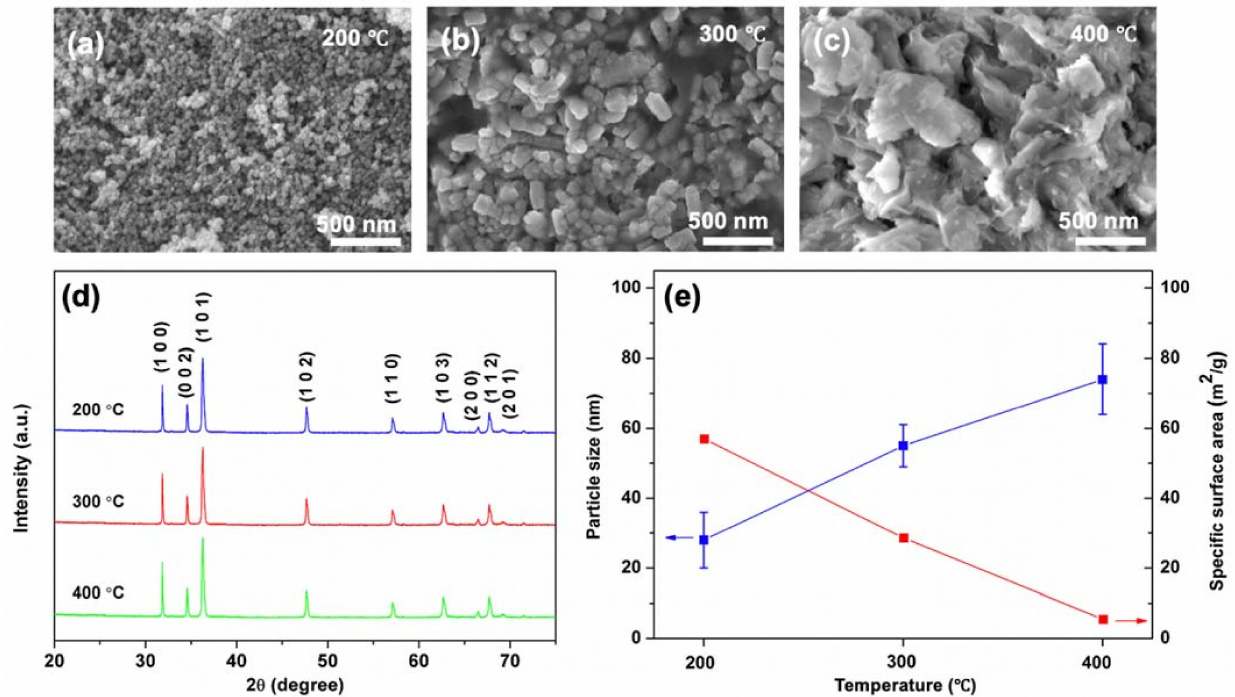
Figure 1. FE-SEM micrographs showing the morphology of of ZnO NPs derived from various calcination temperatures at: ( a ) 200 ◦ C; ( b ) 300 ◦ C; and ( c ) 400 ◦ C. ( d ) X-ray diffraction patterns of the ZnO NPs after calcination at the corresponding temperatures. ( e ) Specific surface area and particle size with deviation of ZnO NPs calcined at different